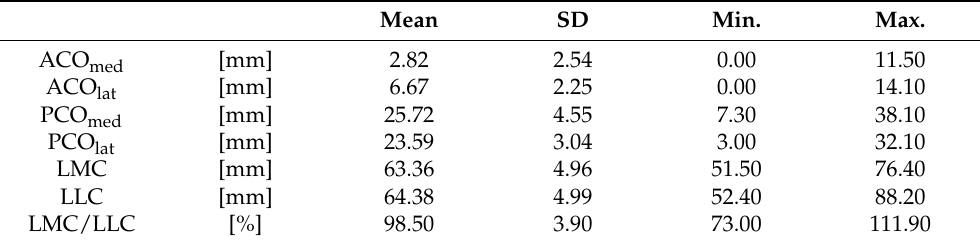
Table 2. Descriptive analysis of femoral condylar morphology in patients without radiological structural damage or manifest osteoarthritis ( n =